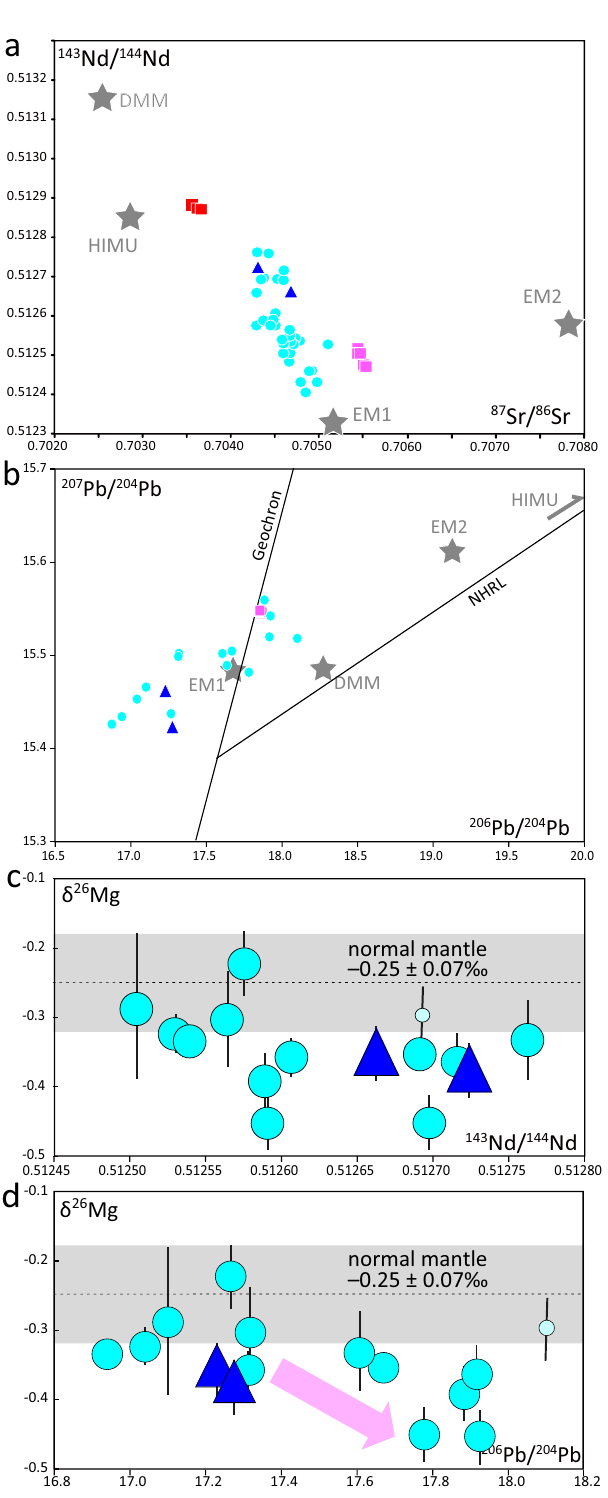
samples FeO * /MgO = 0.92 – 1.36 for G1 basalts and 0.78 – 1.08 for